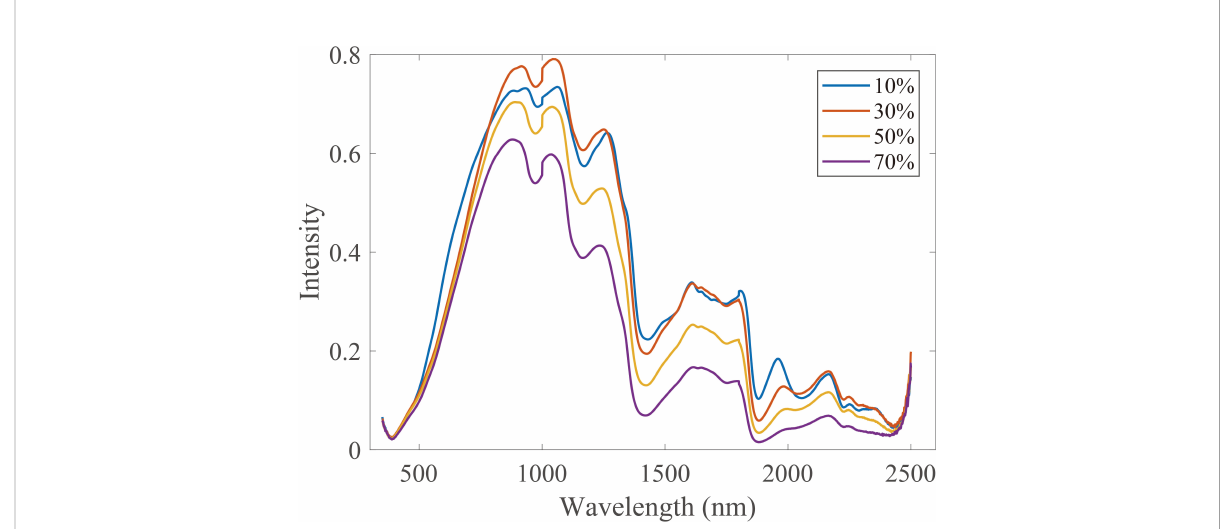
FIGURE 3 Vis-NIR spectra for wood samples with different moisture content (10%, 30%, 50%, and 70%). Vis-NIR, visible –